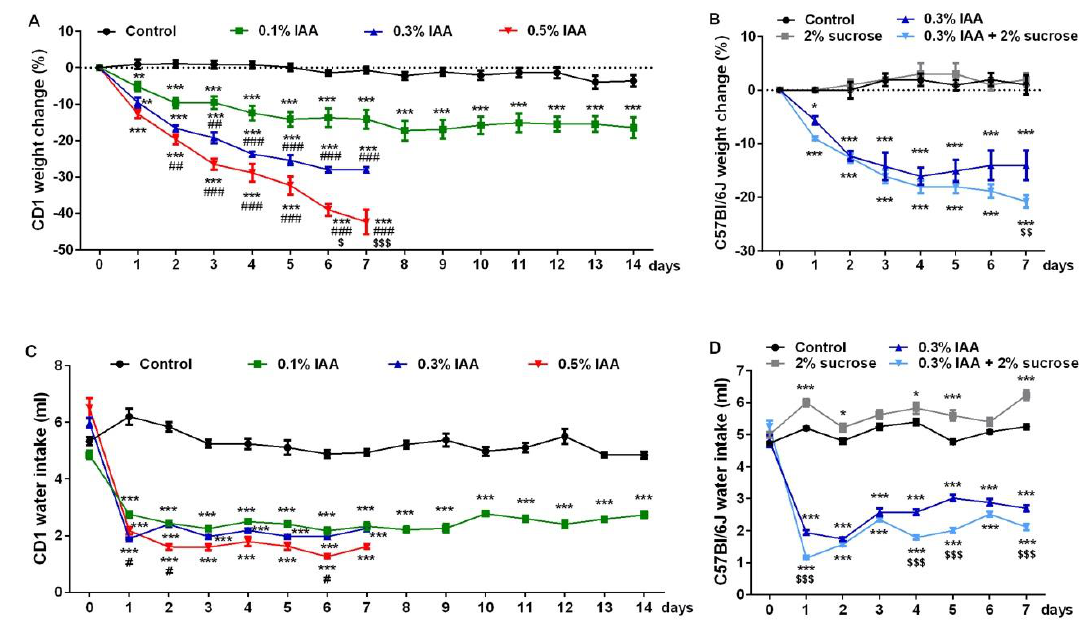
Figure 8. IAA-induced weight change and water intake in mice. IAA administration resulted in ( A , B ) a dose-dependent weight loss and ( C , D ) significantly reduced water intake in both CD1 and C57Bl / 6J mice, respectively. Data are shown as means ± SEM; n = 6 / group (repeated-measures ANOVA followed by Bonferroni’s modified t -test; * p < 0.05, ** p < 0.005, *** p < 0.0005 vs. control group; # p < 0.05, ## p < 0.005, ### p < 0.0005 vs. 0.1% IAA group, $ p < 0.05, $$ p < 0.005, $$$ p < 0.0005 vs. 0.3% IAA group).